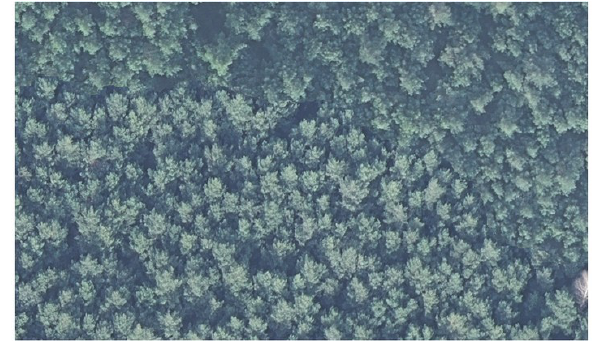
Figure 11. An example of an orthomosaic of a forest area (where is the